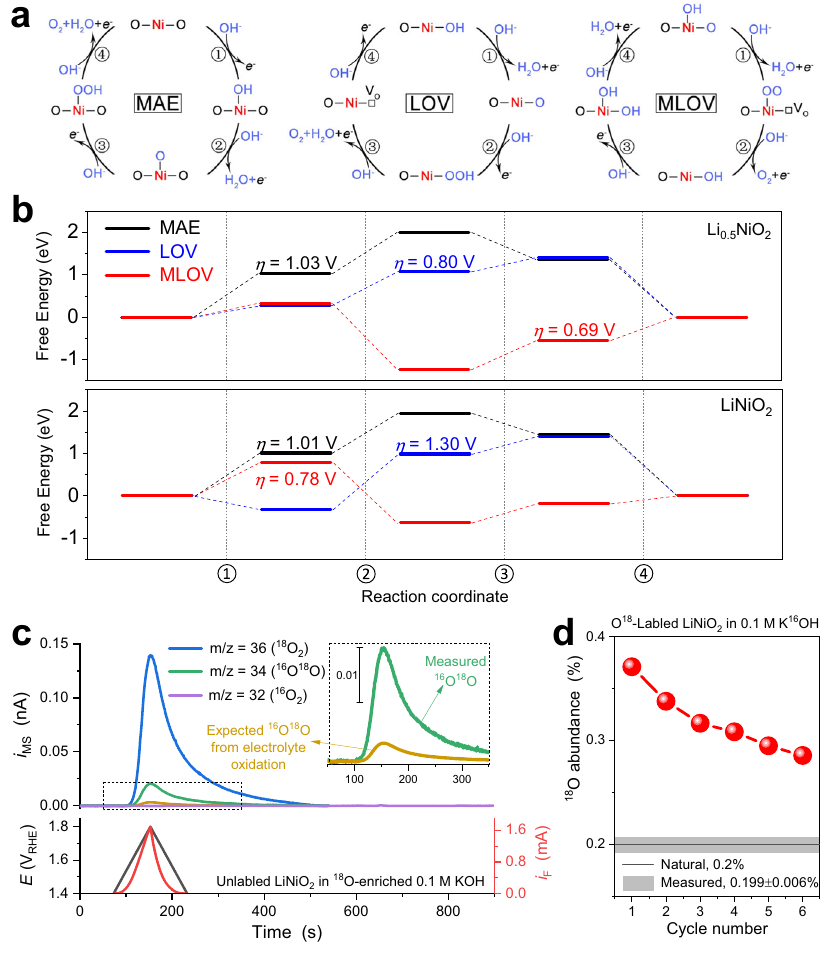
Fig. 7 | The OER mechanism of LiNiO 2 . a Schematic 4-step reaction pathways of MAE,LOV,andMLOVOERmechanisms.FreeenergyofeachOERstepof b Li 0.5 NiO 2 and LiNiO 2 at U RHE =1.23V. The estimated thermodynamic overpotentials of each potential-determining step are labelled. c MSCV and faradicCVcurvesrecorded in 18 O-enriched 0.1M KOH electrolyte prepared using H 2 18 O (99% 18 O), showing the massioncurrent( i MS )of 18 O 2 , 16 O 18 Oand 16 O 2 alongwiththefaradaiccurrent( i F )and the applied potential E from the fi rst CV scan. (The inset of c ) Comparison of the